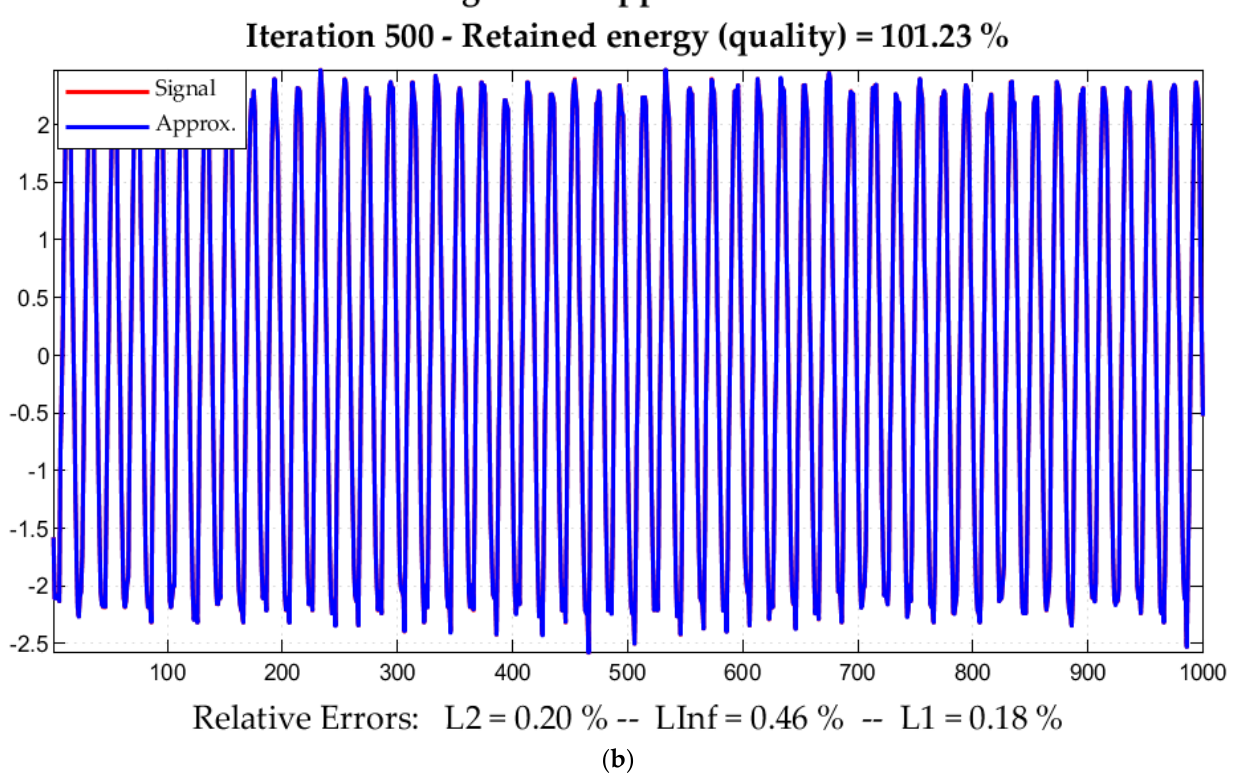
Figure 5. Stator current ( I (cid:2870) ) signal using OMP for One-Broken Rotor Bar fault, operating at 1480 rpm. ( a ) Indices of selected coefficients; ( b ) Original signal and its components. ( a ) Indices of selected coefficients; ( b ) Original signal and its